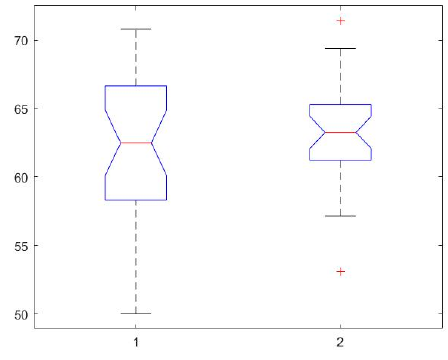
Figure 21. ANOVA test, POCID indicator.